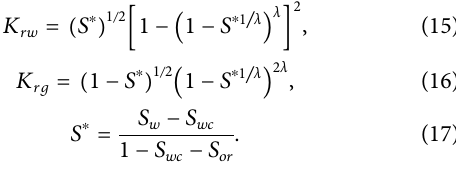
Frontiers in Earth Science |